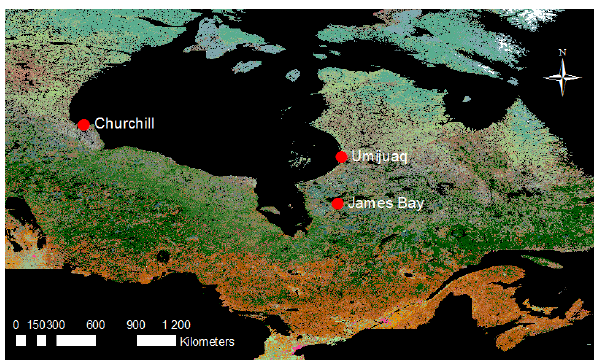
Figure 1. Location of field campaigns. Background: Land Cover of Canada (Latifovic et al.,